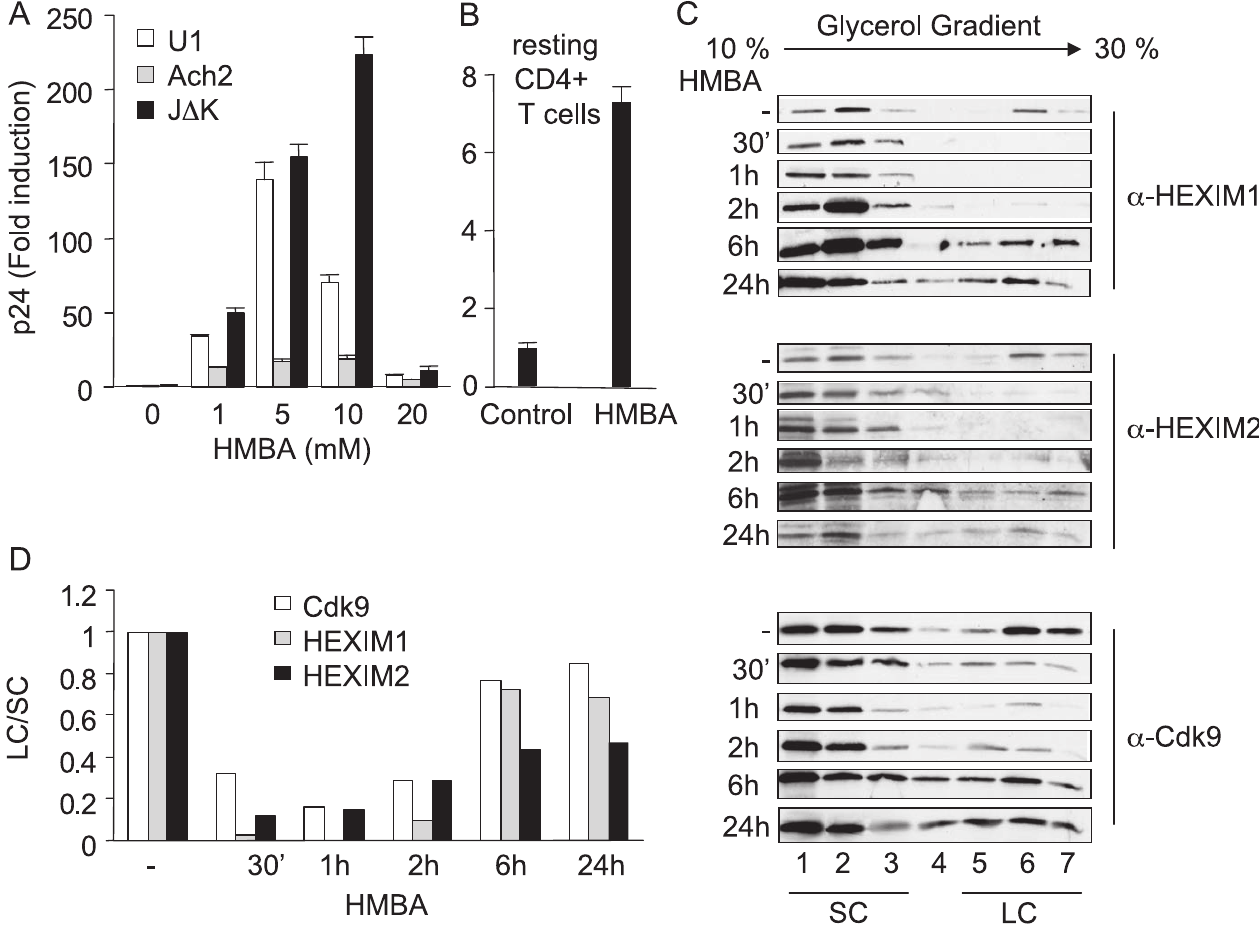
Figure 1. HMBA Transiently Disrupts the LC (A) U1, Ach-2, and J D K cells were stimulated with increasing concentrations of HMBA (1, 5, 10, and 20 mM) and viral production was assessed at 48 h in the supernatant using p24 ELISA. (B) Resting CD4 þ T cells, which were isolated from PBMCs that were infected with HIV-1 LAI and rested for 11 d were treated or not with HMBA (1 mM) for 3 d. Viral production was assessed using p24 ELISA. (C) Total cell lysates of Jurkat cells stimulated or not with HMBA (5 mM) for 30 min, 1 h, 2 h, 6 h, and 24 h, were subjected to glycerol gradient sedimentation analyses (10%–30%), and the fractions were analyzed by western blotting using HEXIM1, HEXIM2, and Cdk9 antibodies. Numbers below the western blots correspond to fractions from glycerol gradient analyses. (D) LC/SC represents the ratio of cumulated intensities of fractions 5, 6, and 7 (LC) over intensities of fractions 1, 2, and 3 (SC). Values were normalized to ratios obtained in unstimulated cells.